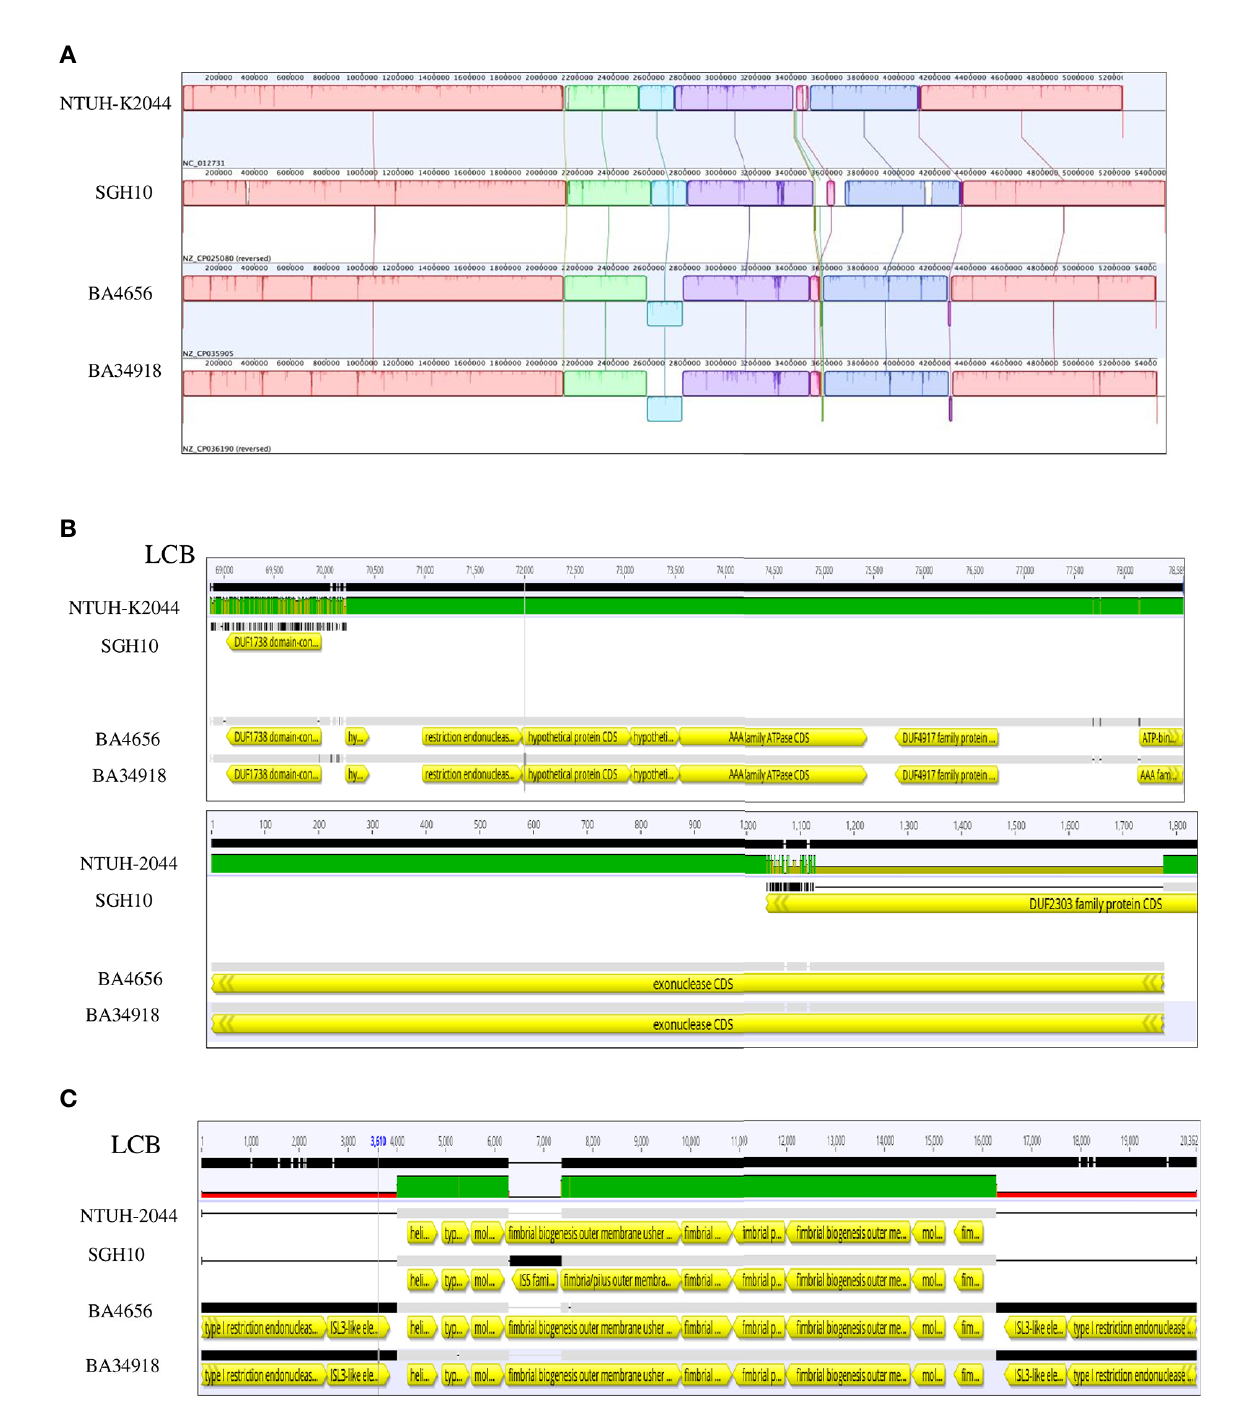
FIGURE 2 | Alignment of chromosomes of Klebsiella pneumoniae isolates BA4656 (NZ_CP035905) and BA34918 (NZ_CP036190) with reference genomes SGH10 (NZ_CP02580) and NTUH-K2044 (NC_012731). (A) 12 locally co-linear blocks (LCBs) of all four strains are shown. (B) Presence of restriction endonucleases (LCB 6) and exonucleases (LCB 2) in the clinical isolates and not in the reference strains. (C) The biosynthetic operon of the fi m gene (LCB 11) shown here is fl anked by the IS3 like insertion sequence in the clinical isolates and not in the reference